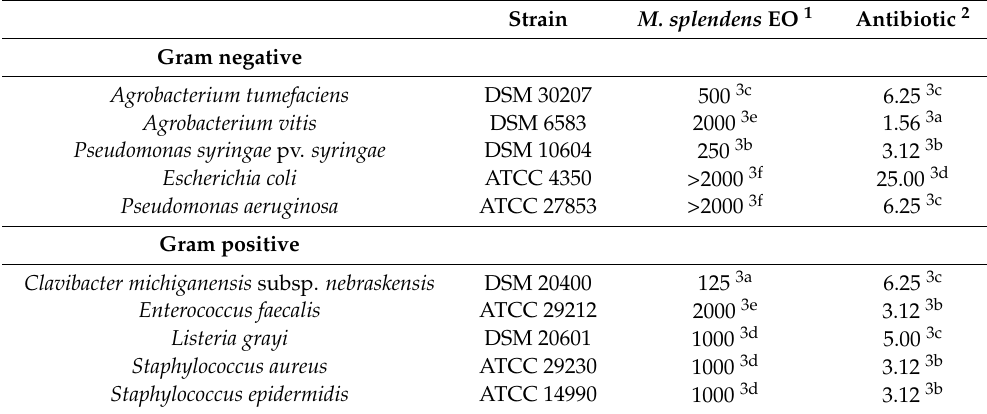
Table 3. Antibacterial activity of M. splendens essential oil expressed as MIC (Minimum Inhibitory Concentration) ( µ